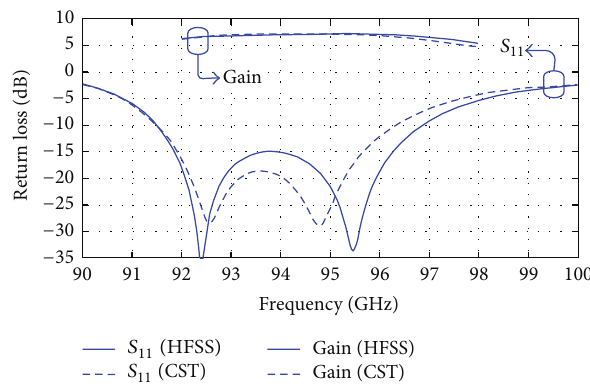
Figure 4: Simulated return loss 𝑆 11 and realized